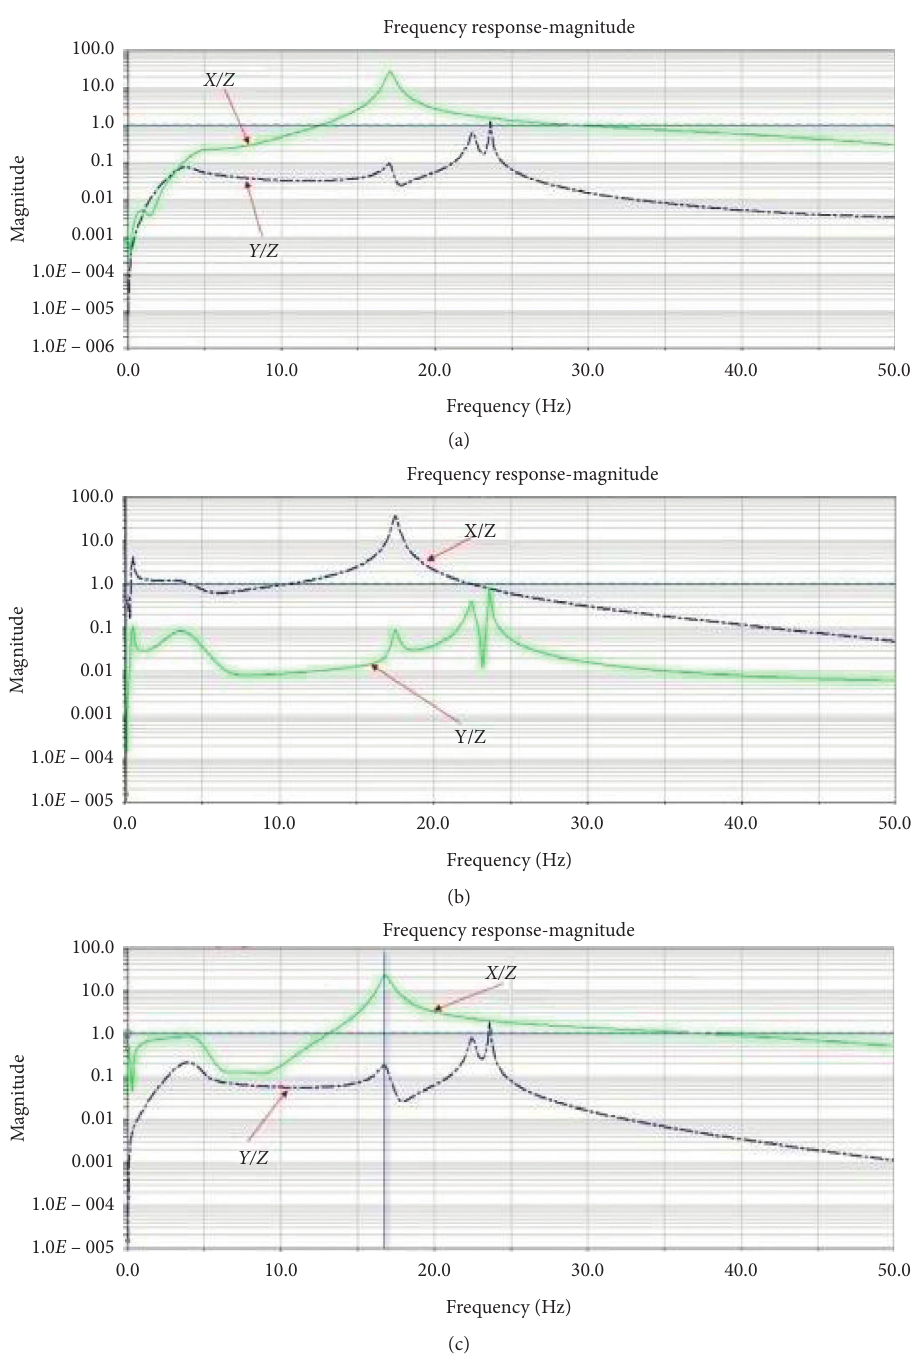
Figure 12: The frequency responds in (a) vertical motion, (b) back jump motion, and (c) forward jump